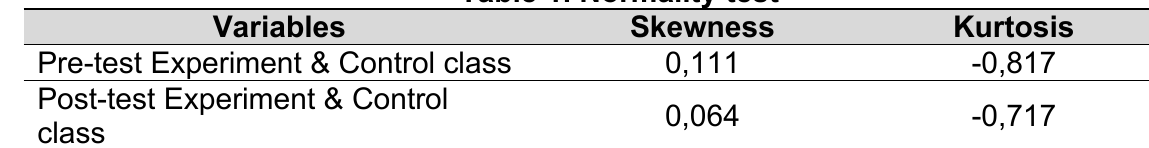
Table 1. Normality test